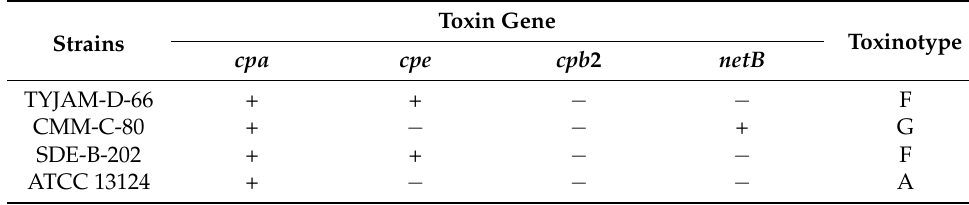
Table 2. Toxin gene profiles of C. perfringens isolates